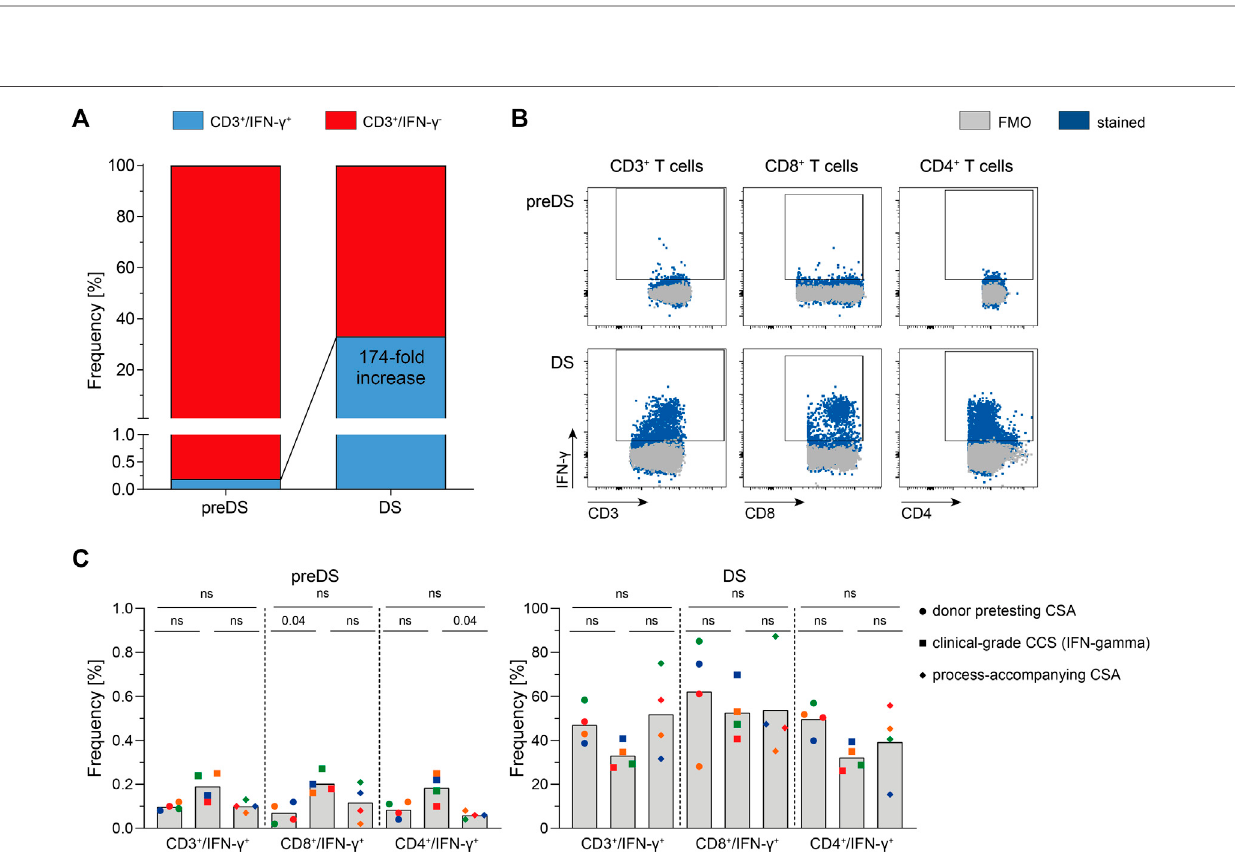
FIGURE 2 | Clinical manufacturing of SARS-CoV-2-speci fi c T cells ( n = 4). SARS-CoV-2-speci fi c T cells were magnetically enriched under GMP-compliant conditions using Cytokine Capture System (CCS) and CliniMACS Prodigy and analyzed via fl ow cytometry. (A) Enrichment of SARS-CoV-2-speci fi c Interferon-gamma (IFN- γ )-secreting T cells using CCS and CliniMACS Prodigy. Data are shown as mean of data obtained from n = 4 manufacturing processes. (B) Representative FACS plots depicting IFN- γ production in indicated T cell subsets of in-process control (pre-enrichment; preDS) and the magnetically enriched T cell product (drug substance,DS). (C) Summarizedresultsofclinical-grademanufacturingincomparisontocorrespondingdonorpretestingCytokineSecretionAssay(CSA)andprocess- accompanying CSA. Bars represent mean, each symbol represents data obtained from one donor (same colors indicate matched data), n = 4 convalescent COVID-19 patients. Statistical analysis was performed using Friedman Test, followed by Dunn ’ s multiple comparison; ns not signi fi cant.